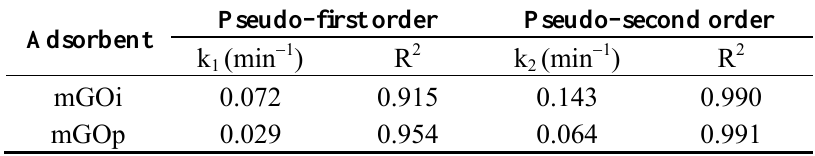
Table 1. Kinetic constants for RB5 removal with mGOi and mGOp at 25